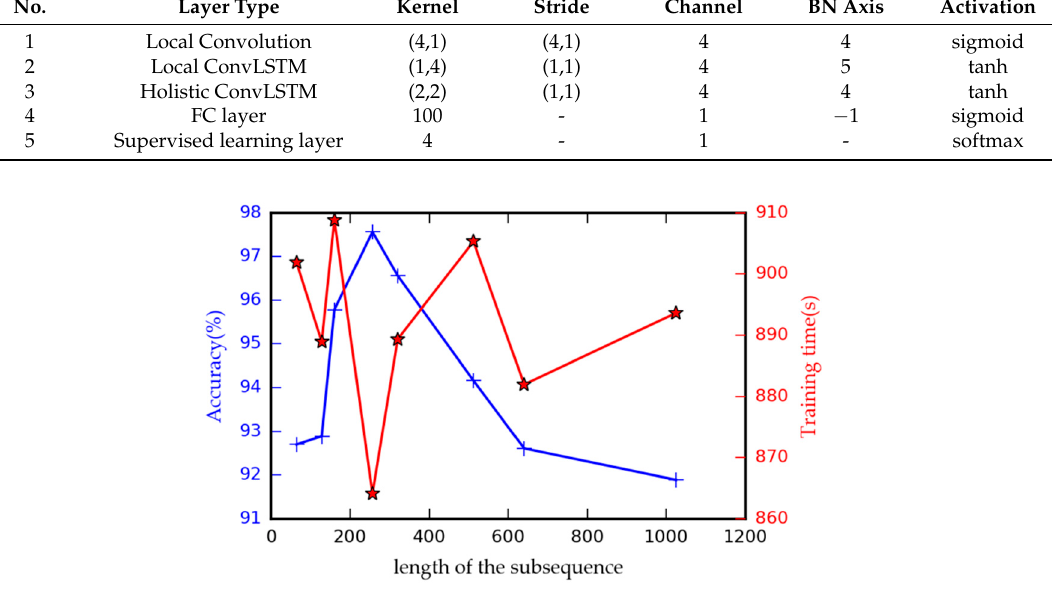
Figure 6. Accuracy and training time under different length of the subsequence.